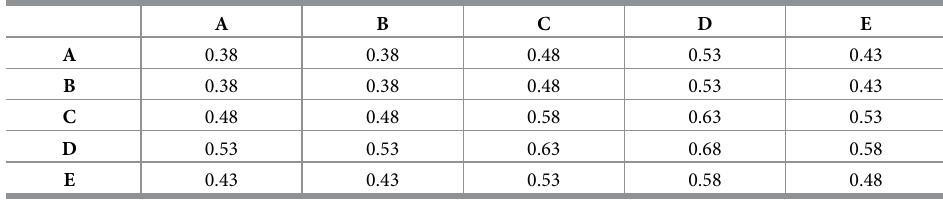
Table 4. Judgment matrix of each factor evaluation